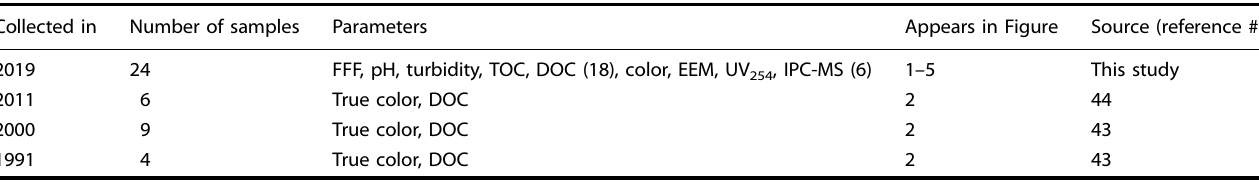
Table 2. Summary of data collection and sources. Collected